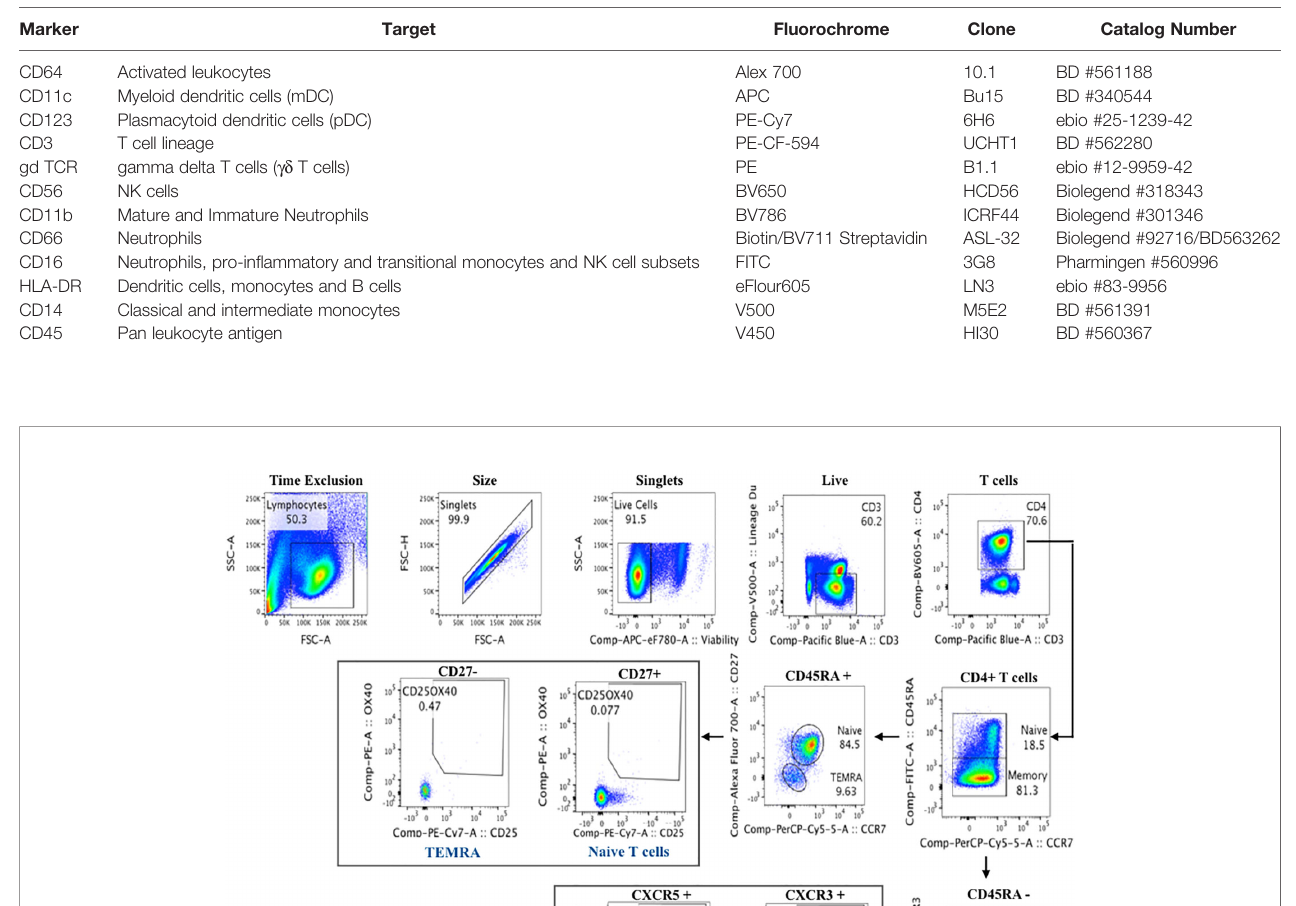
TABLE 5 | Antibody panel for single cell